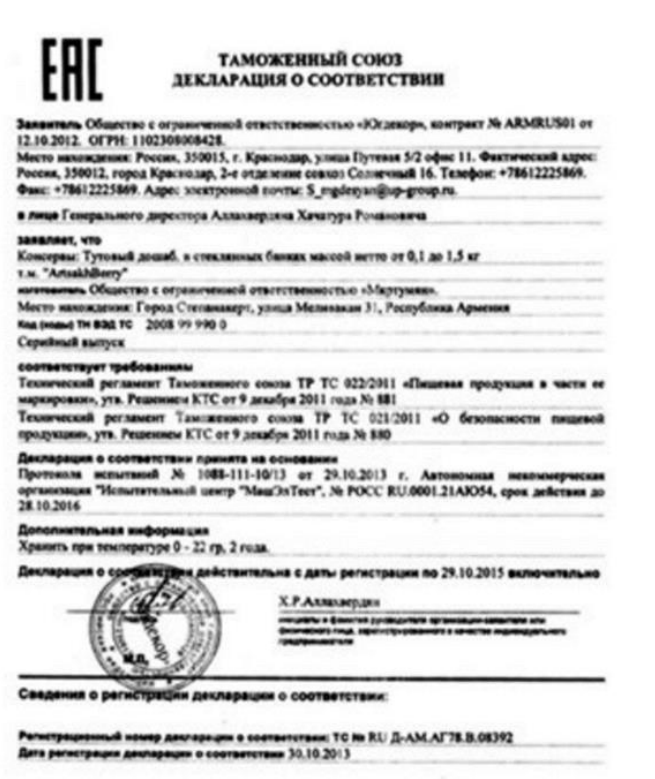
Figure 4. “ArtsakhBerry” products declaration of Customs by the Customs Union in Russia, Kazakhstan, Belarus, Armenia, Kyrgystan for the written that the products originate in “The town of Stepanakert, Melivakan Street 31, Armenia